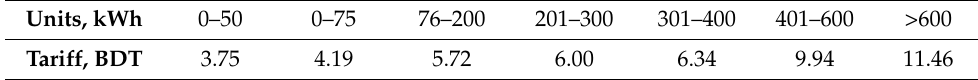
Table 5. Electricity tariff in Bangladesh.